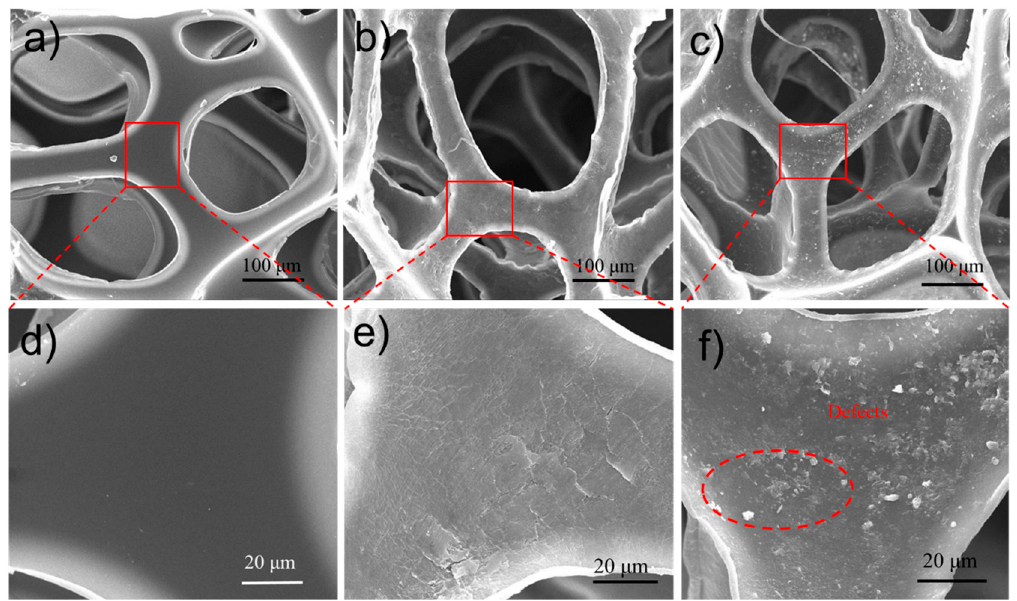
Figure 7. SEM images of control FPU foam ( a , d ); MMTNS ‐ 2 ‐ ( b , e ); and MMTNS ‐ 1 ‐ ( c , f ) coated foams at different magnification.